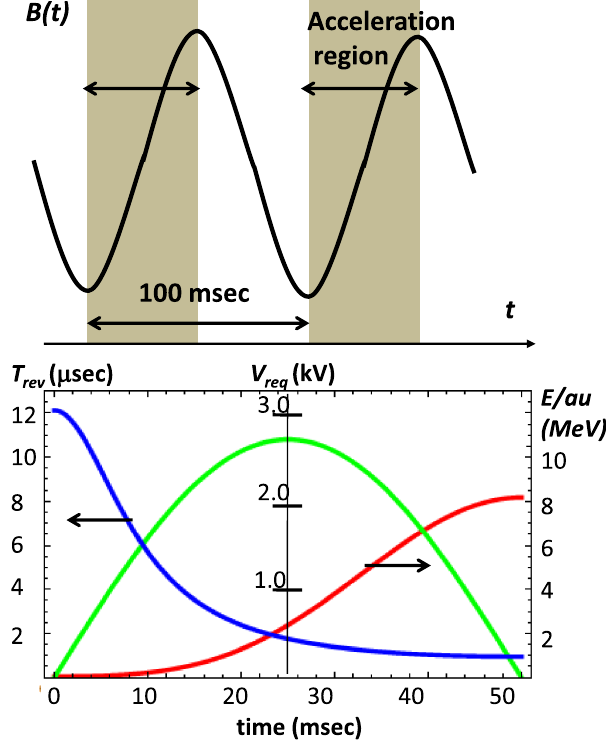
FIG. 4 (color online). Ramping pattern of magnetic flux density, required acceleration voltage per turn V period T (blue), and energy per nucleon (red) vs rev